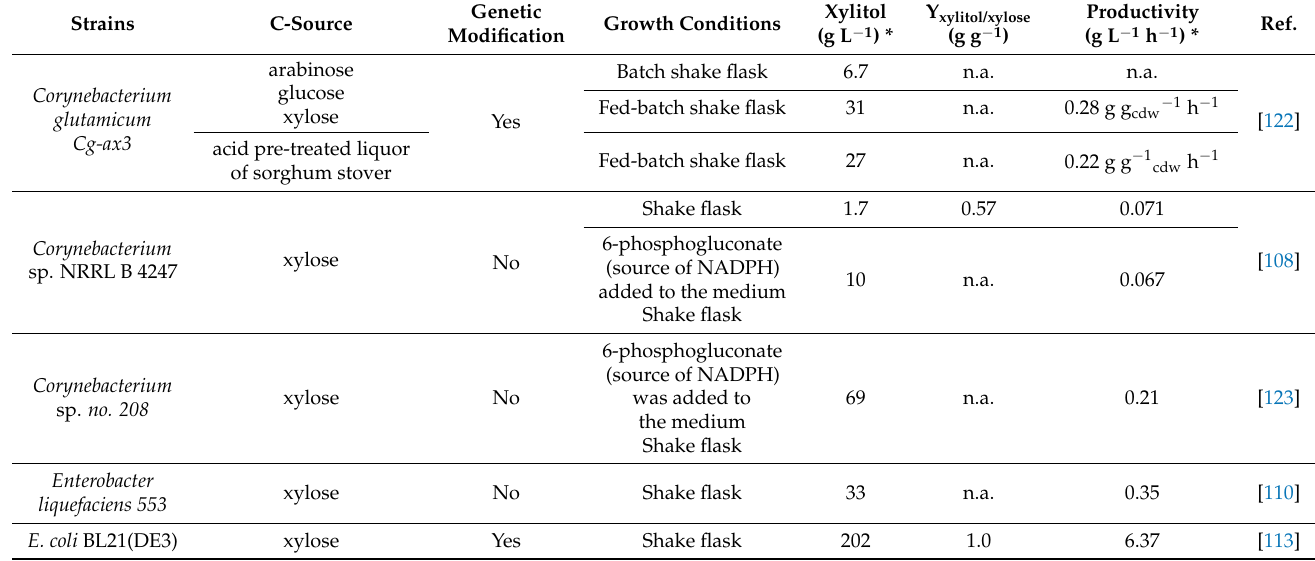
Table 1. List of bacteria (wild type and genetically modified) with potential for D-xylitol production from lignocellulosic biomass (n.a.—information not